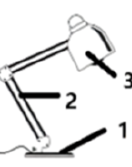
Figure 2. Part structure schematic diagram of a lamp.